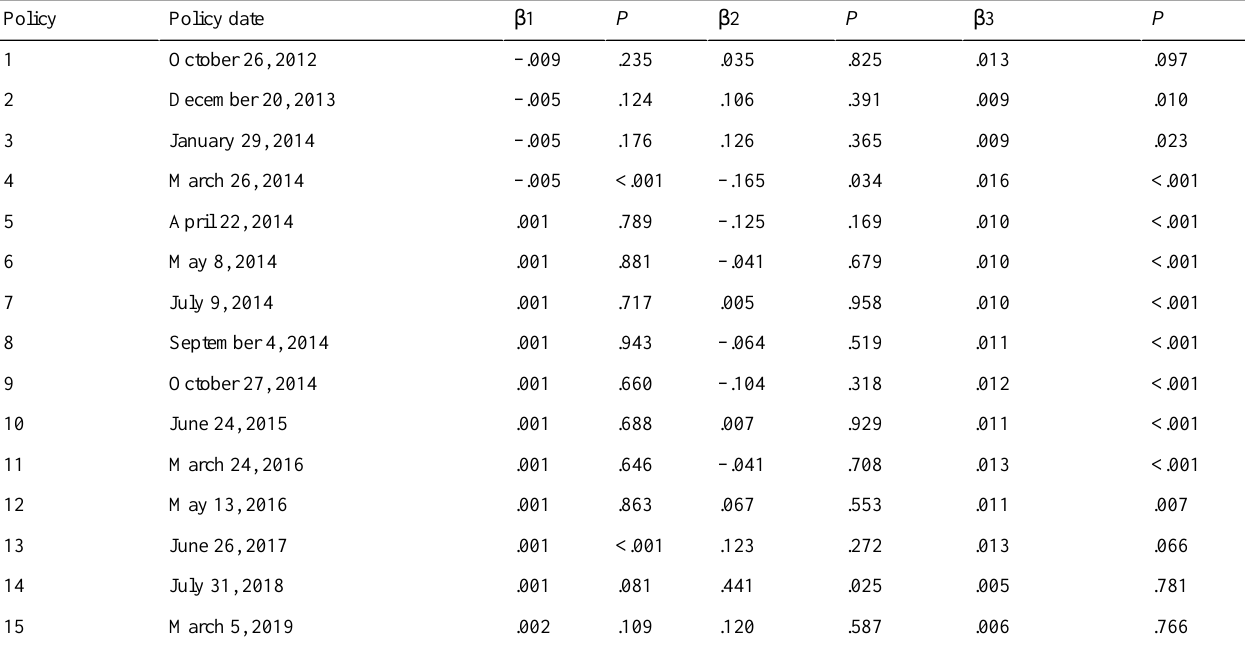
Table 7. Support doctor regression parameters at 15 policy time points.